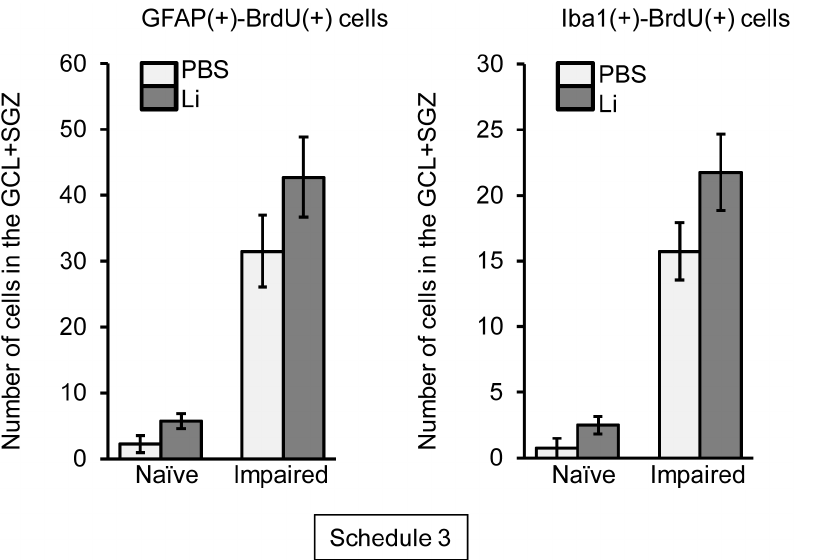
Figure 6. Effect of lithium (Li) on glial differentiation of BrdU( + ) cells generated following neuronal loss. Animals were given either lithium carbonate (100 mg/kg, i.p.) or PBS with BrdU on day 2 post-treatment with PBS or TMT, subsequently given once a day either lithium carbonate or PBS up to day 15, and then decapitated on day 30 post-treatment for preparation of sagittal hippocampal sections, which were then stained with antibodies against GFAP or Iba1 and BrdU (Schedule 3). The graphs denote the number of double-positive cells in the GCL + SGZ of the 4 groups. Values are expressed as the mean 6 S.E. calculated from 4 animals.